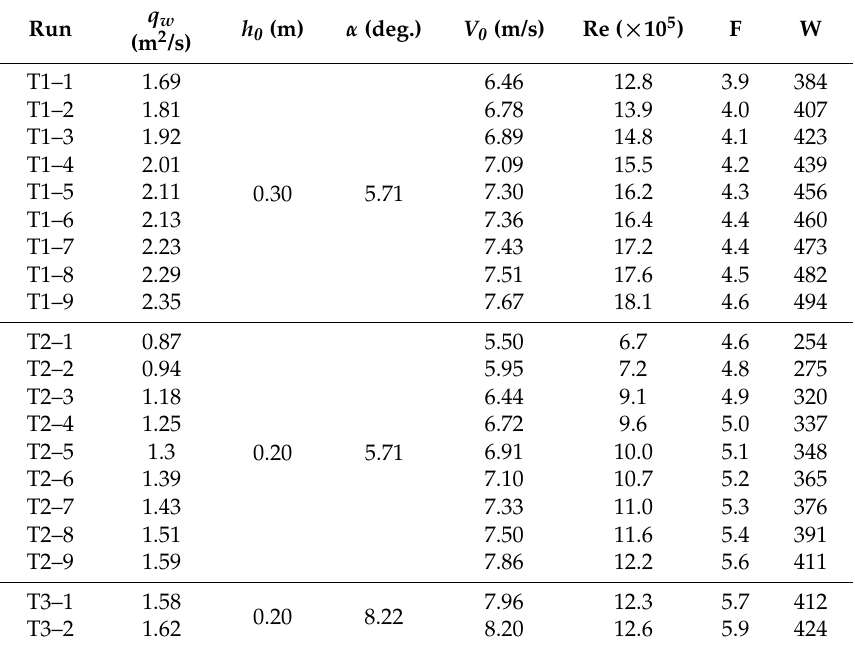
Table 1. Experimental flow conditions.